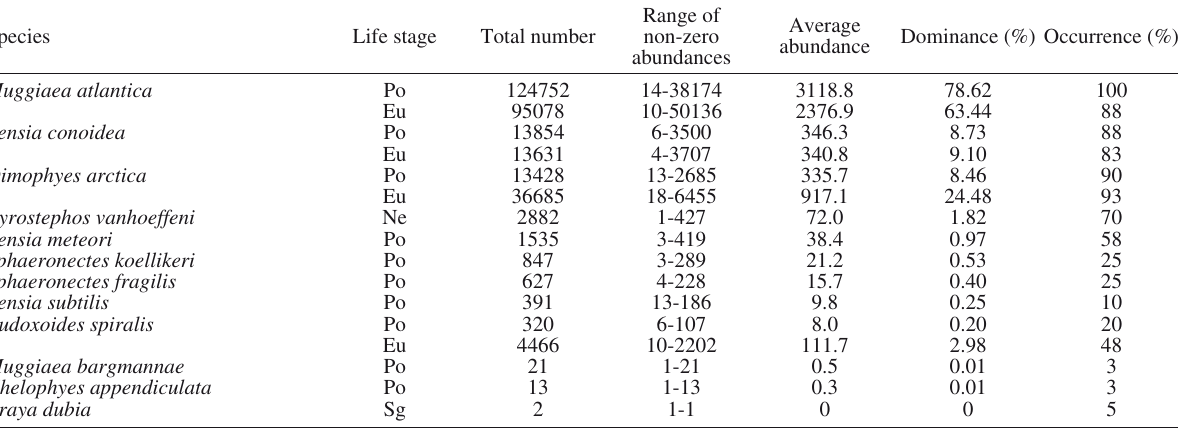
Table 1. – Summary of basic statistics for polygastric (po) and eudoxid or sexual (eu) stages of siphonophores. Total number of individuals, range of abundances, average per station, dominance and occurrence. Abundances are expressed as ind 1000 m –3 . Ne, nectophores; Sg, stem group.